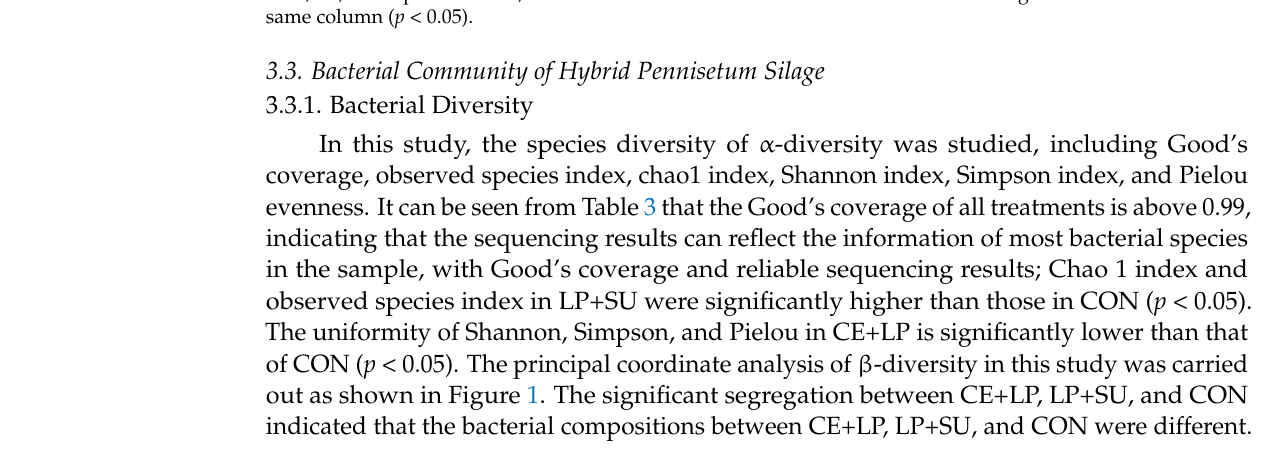
Table 3. The α -diversity of bacterial community of hybrid Pennisetum